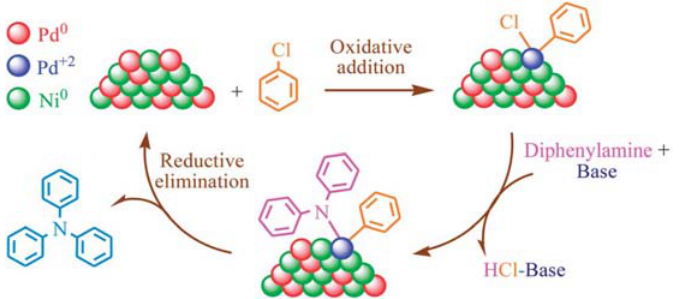
Figure 3. Catalytic pathway of the amination reaction on the surface of Pd 0.5 Ni 0.5 BMNPs. Reproduced from reference [30] with permission of The Royal Society of Chemistry.